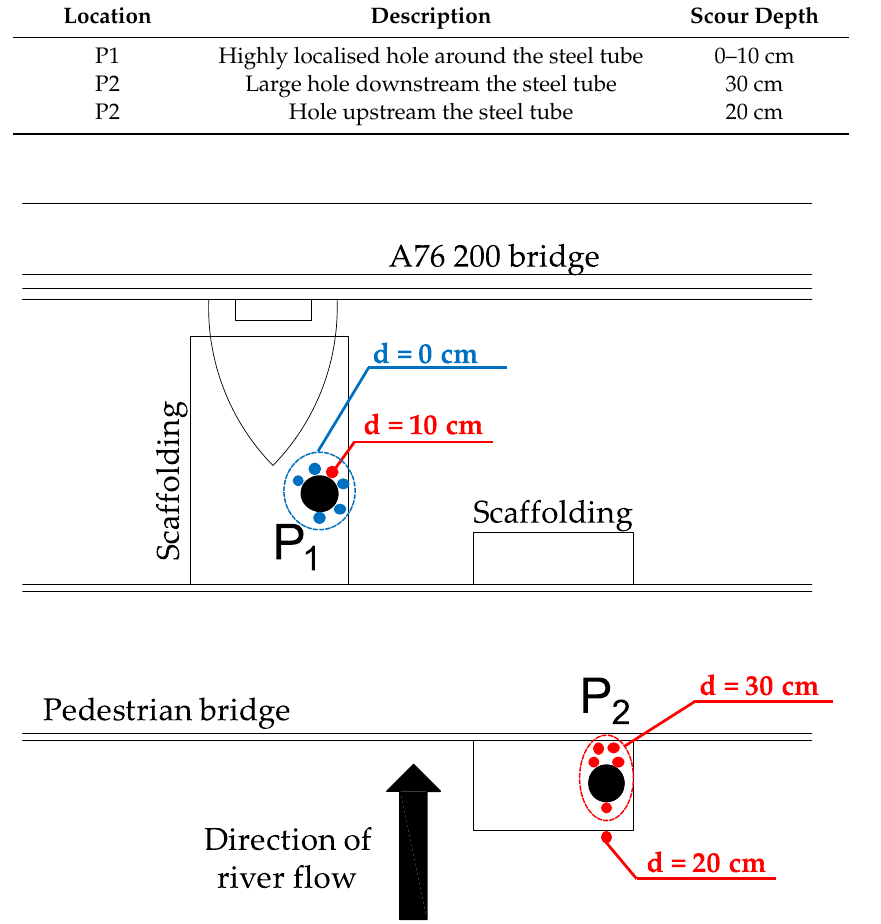
Figure 23. Locations and scour measurements carried out during the probe inspection.